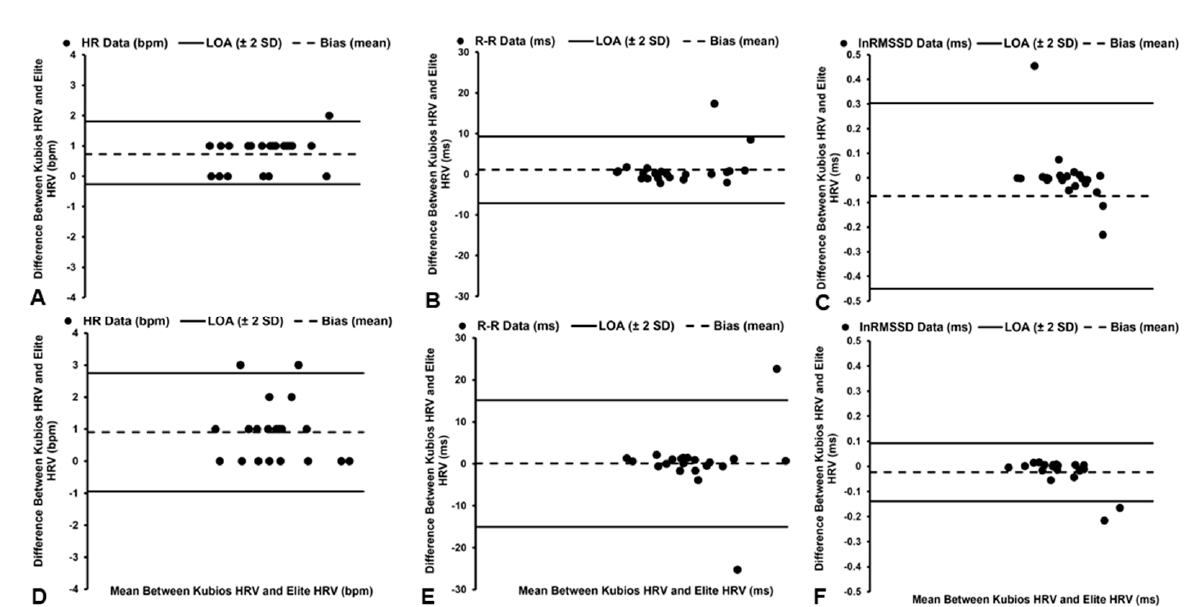
Figure 5. Bland–Altman plots demonstrating the mean bias and limits of agreement (LoA) of heart rate (HR, A ), R–R interval ( B ), and natural log of root mean square of successive differences (lnRMSSD, C ) data in the supine position and the mean bias and limits of agreement (LoA) of HR ( D ), R–R interval ( E ), and lnRMSSD ( F ) data in seated position when utilizing Automatic artifact